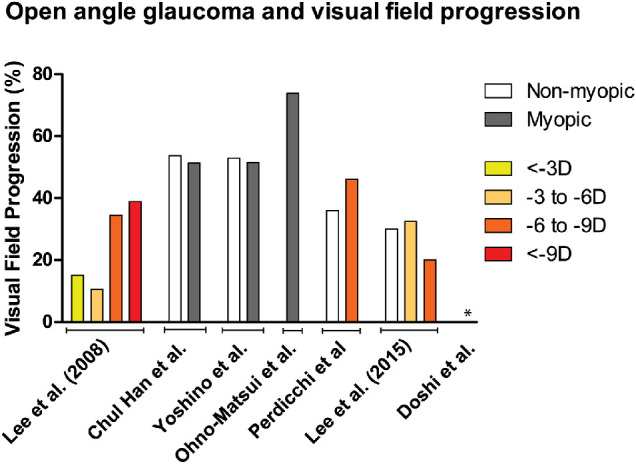
Overview of visual field progression (%) between nonmyopic and myopic patients. Different refractive error categories were indicated by orange patterns. Patients were categorized as myopic if refractive error category was unavailable. Doshi et al.90 found 0% progression in the group SER ≤ –6 D.